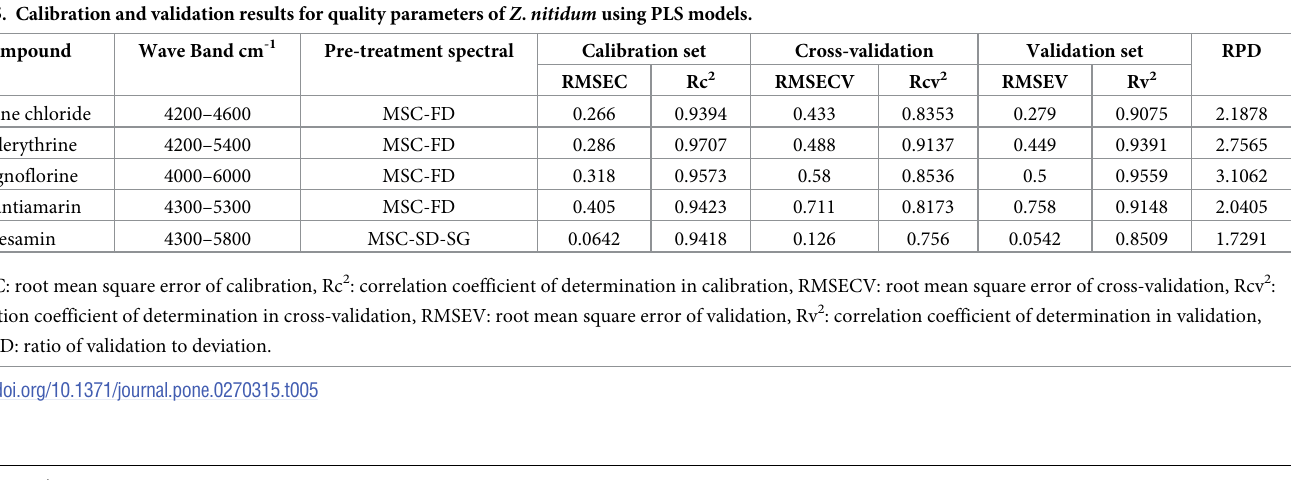
Table 5. Calibration and validation results for quality parameters of Z . nitidum using PLS models. Compound